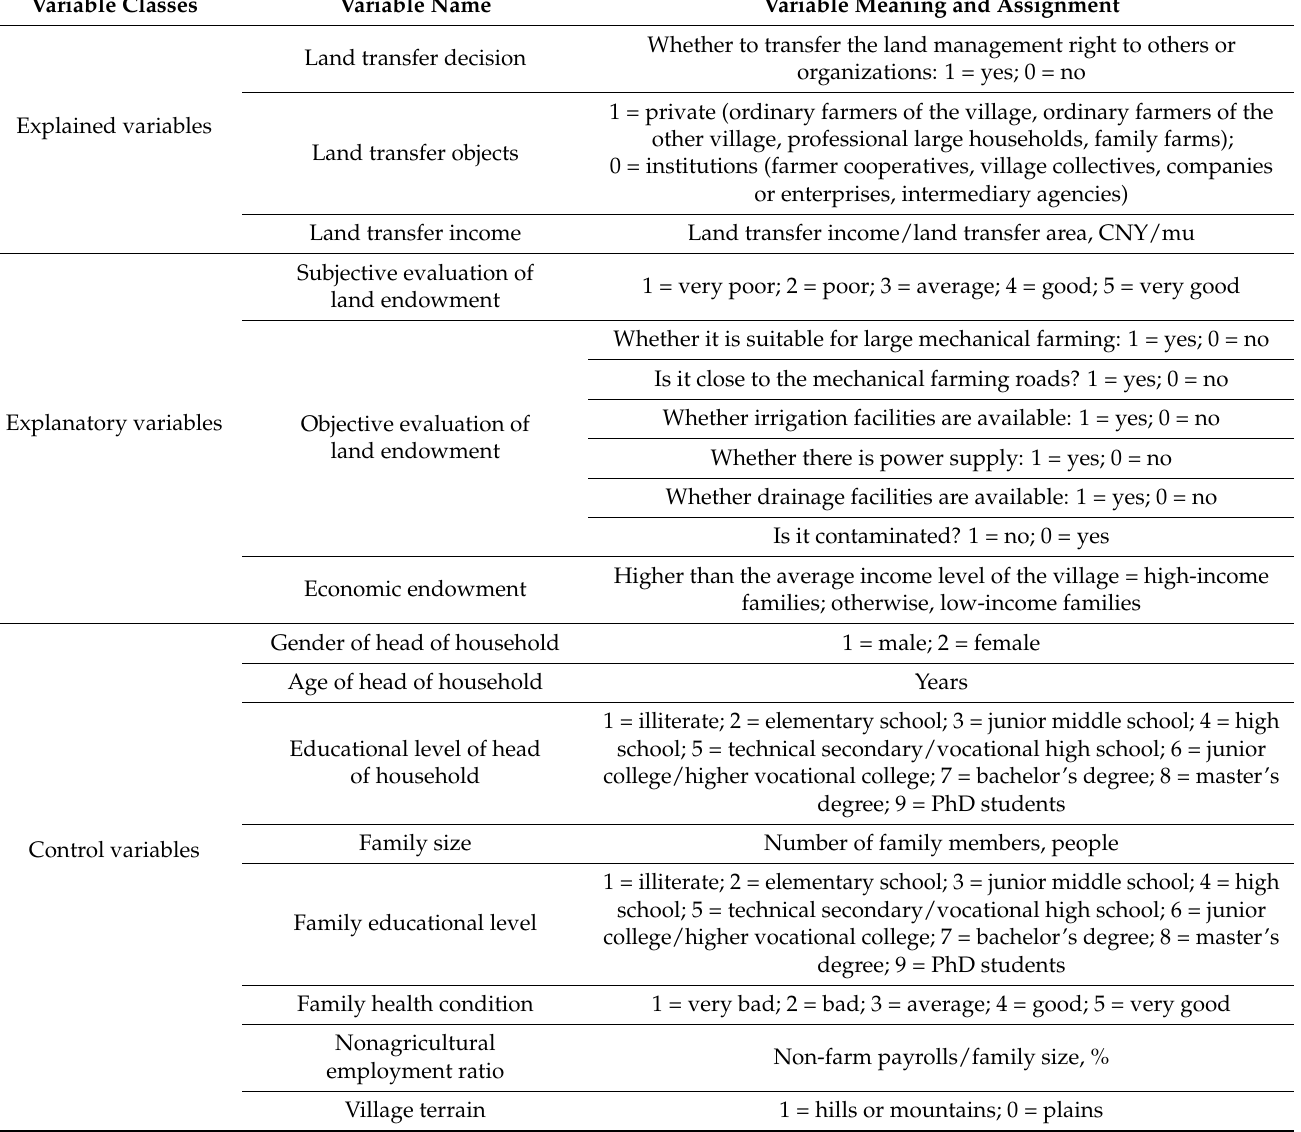
Table 1. Variable selection, definition, and